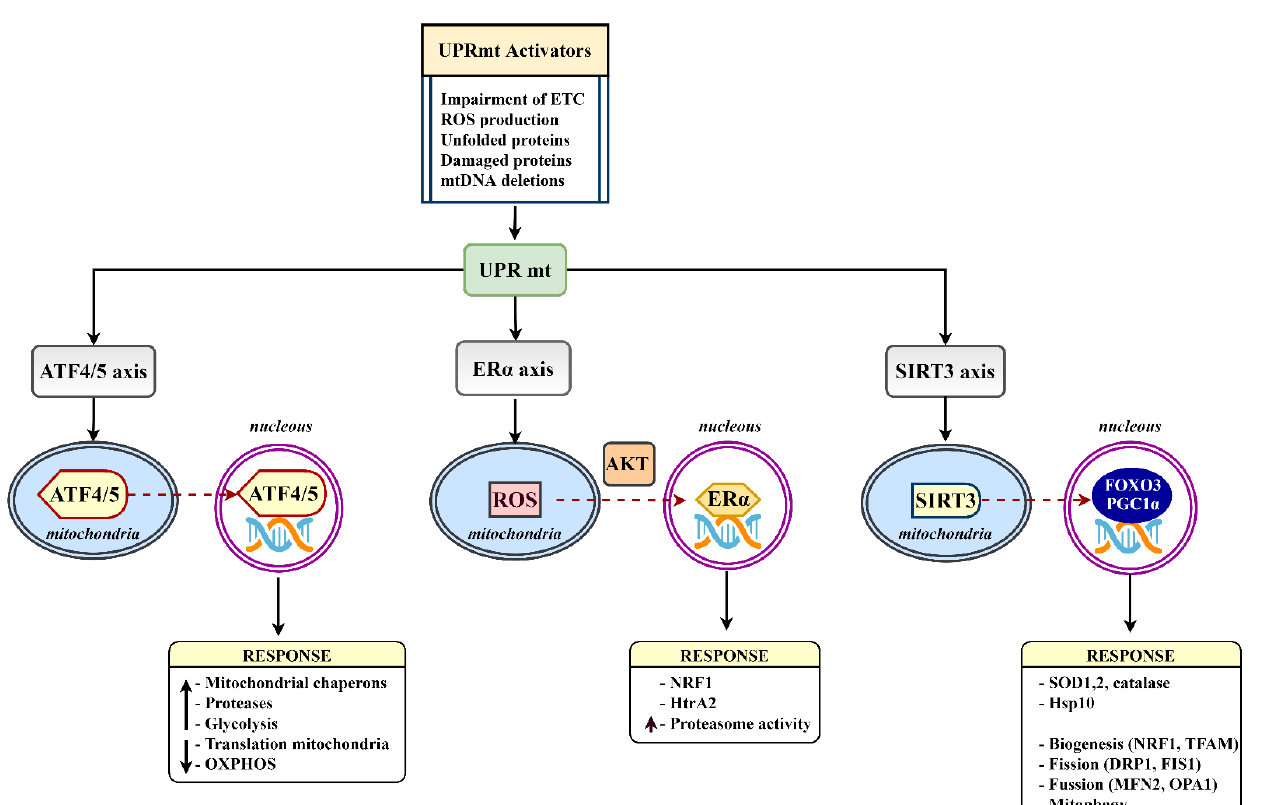
Figure 3. The mammalian UPRmt axes. Various UPRmt activators initiate gene expression via the ATF4/5, Er α , and SIRT3 branches. Triggered signaling pathways lead to a number of mitoprotective outcomes aimed at restoring mitochondrial homeostasis. ATF4/5, activating transcription factor 4/5; ERα, estrogen receptor alpha; DRP1, dynamin -related protein 1; FIS1, mi- tochondrial fission 1 protein; FOXO3, forkhead box protein O3; HTRA2, HtrA serine peptidase 2; MFN2, mitofusin 2; NRF1, nuclear respiratory factor 1; OPA1, mitochondrial dynamin-like GTPase; PGC1α, peroxisome proliferator -activated receptor-gamma coactivator- 1 α; SIRT3, sirtuin 3; TFAM, mitochondrial transcription factor A.